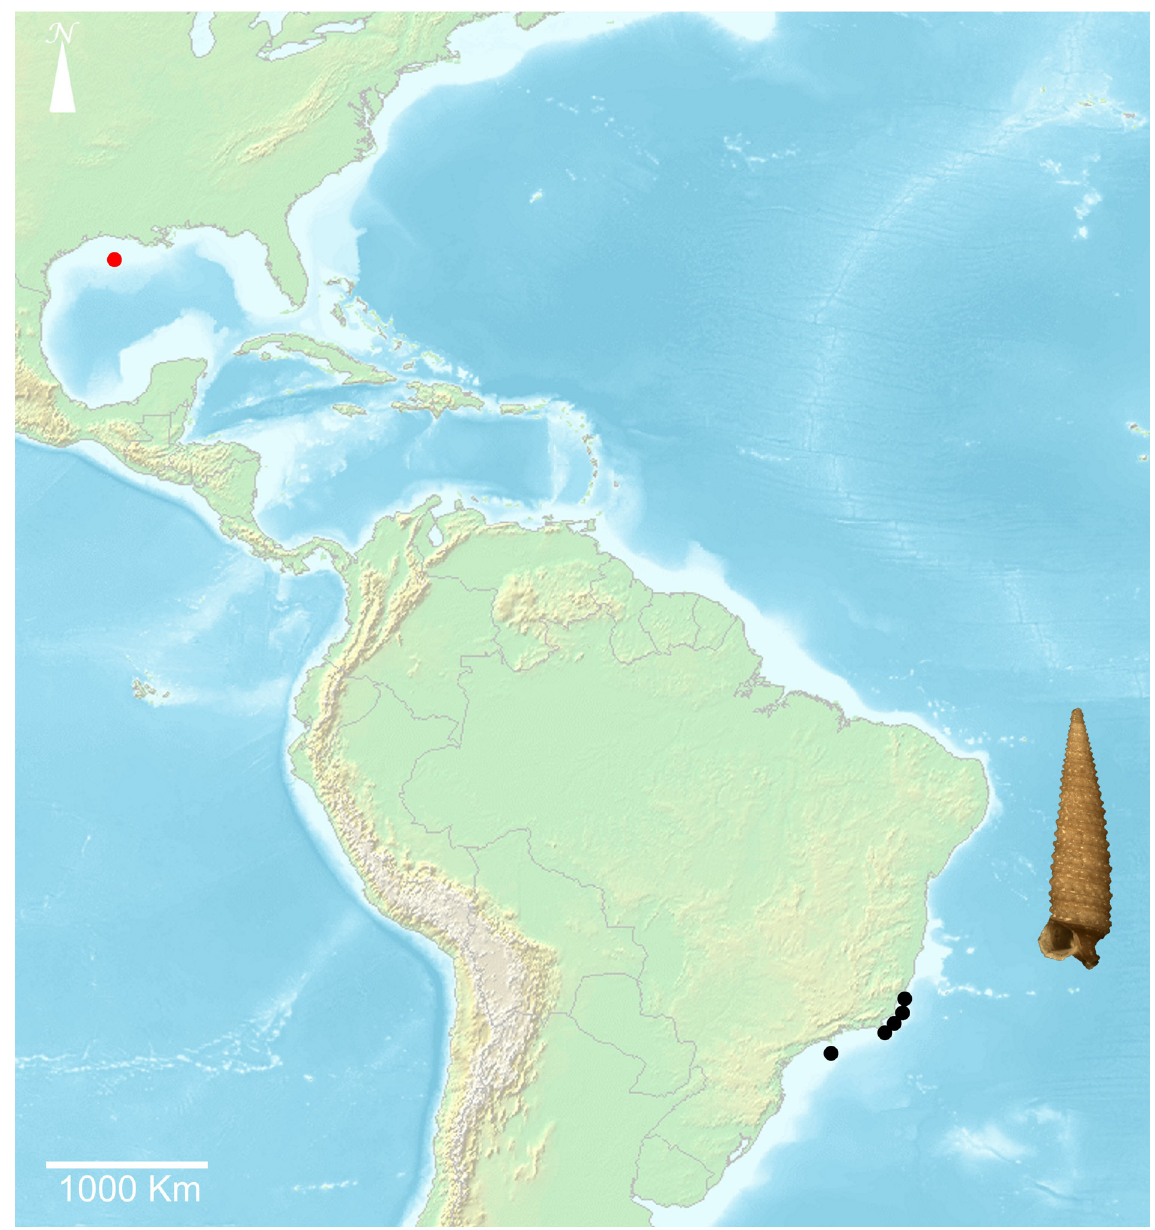
Fig. 38. Distribution map of “ Inella ” faberi Rolán & Fernández-Garcés, 2008; red circle = type